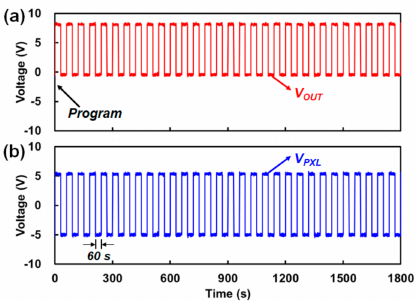
Figure 10. ( a ) Measured output of the source follower. ( b ) Converted pixel voltage using a voltage transfer characteristic. The circuit worked for 30 min after programming